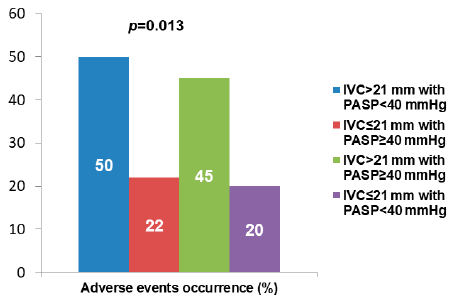
Figure 2. Adverse events rate according to ICV and PASP values.